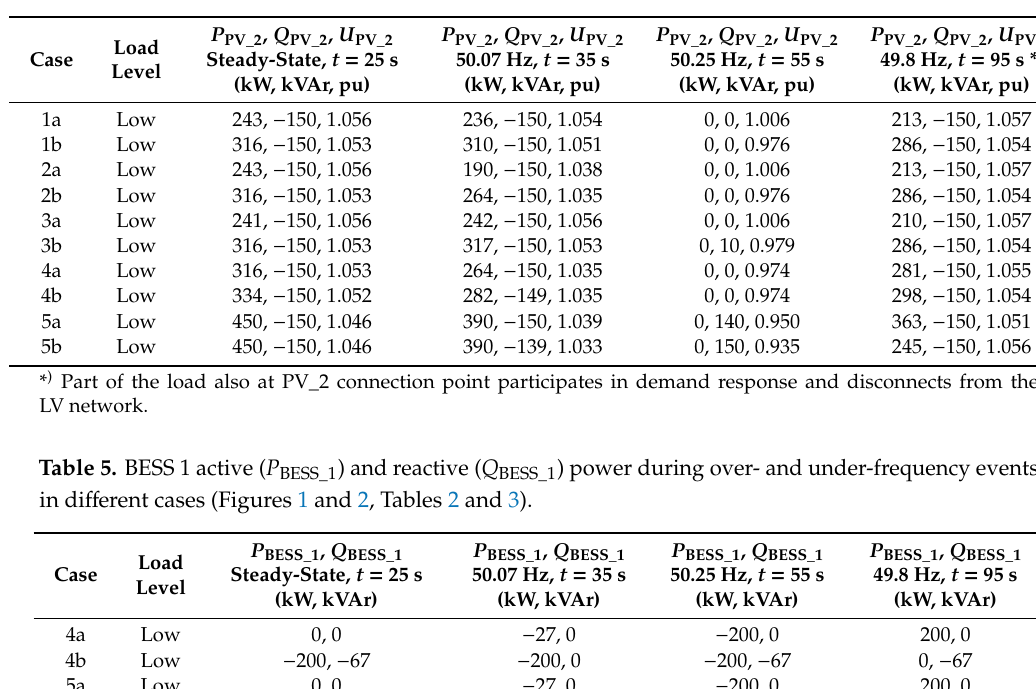
Table 4. PV 2 active ( P PV_2 ) and reactive ( Q PV_2 ) power as well as PV 2 connection point voltage ( U PV_2 ) during over- and under-frequency events in di ff erent cases (Figures 1 and 2, Tables 2 and